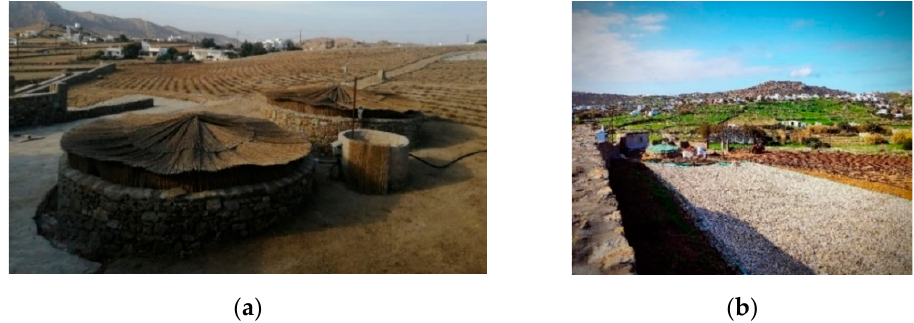
Figure 9. ( a ) Open top water tanks; ( b ) Sub ‐ surface rainwater collection system.